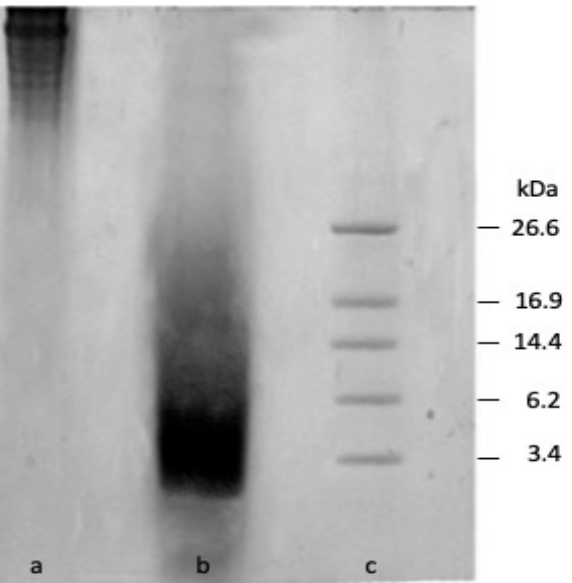
Figure 1. Electrophoresis analysis of squid gelatin hydrolysates (Tricine-SDS-PAGE): a—gelatin, b—hydrolysates, and c—peptide molecular weight marker.